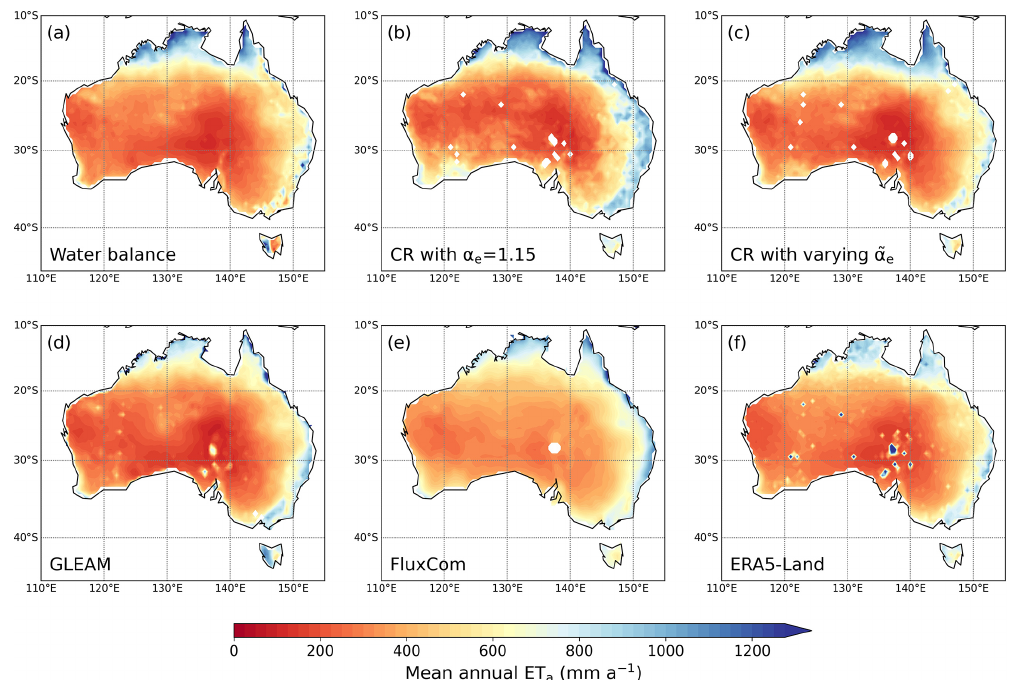
Figure 7. Distributions of (a) the mean annual water-balance ET wb for 1998–2014 and the predictions by (b) CR with α e = 1 . 15, (c) CR with spatially varying ˜ α e , (d) GLEAM, (e) FluxCom, and (f) ERA5-Land.